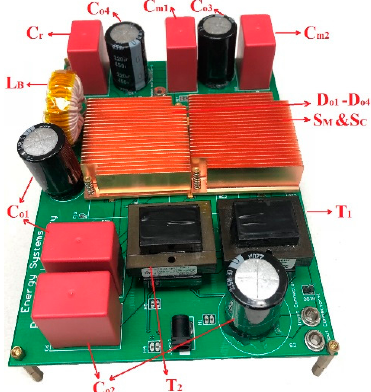
Figure 11. Photo of the implemented prototype.